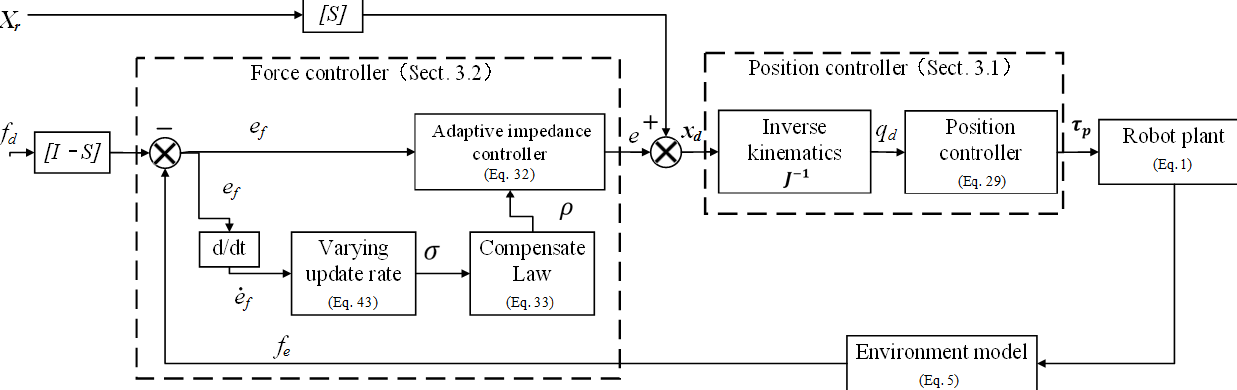
Figure 4. Varying rate adaptive hybrid position–impedance control architecture. This is a cascade architecture in which the position controller tracks the position instructions generated by the impedance controller to achieve compliant